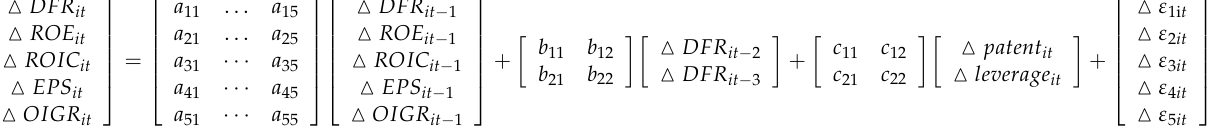
Model 2: Equity financing system